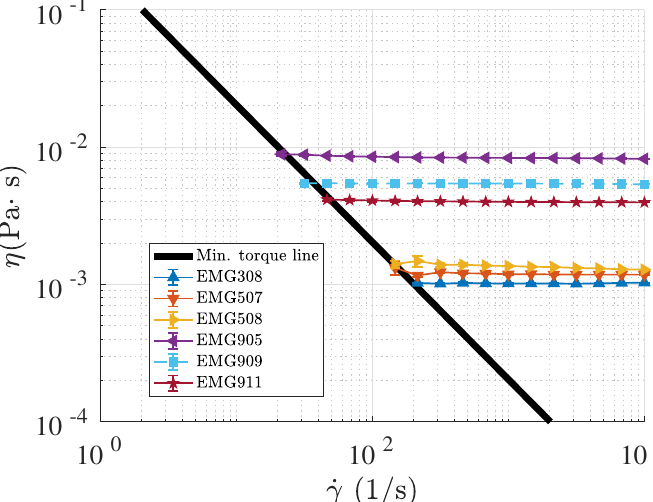
Figure 2. Viscosity curve of the ferrofluids in the absence of an external magnetic